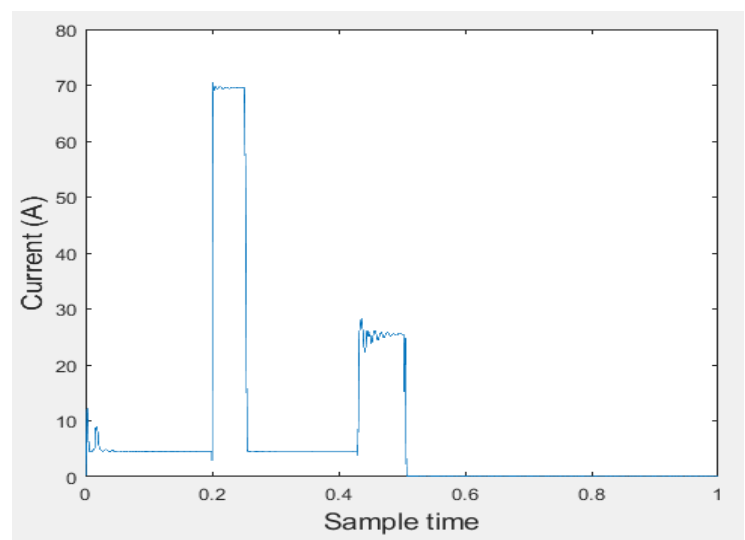
Figure 8. RMS Current signal at the main feeder.